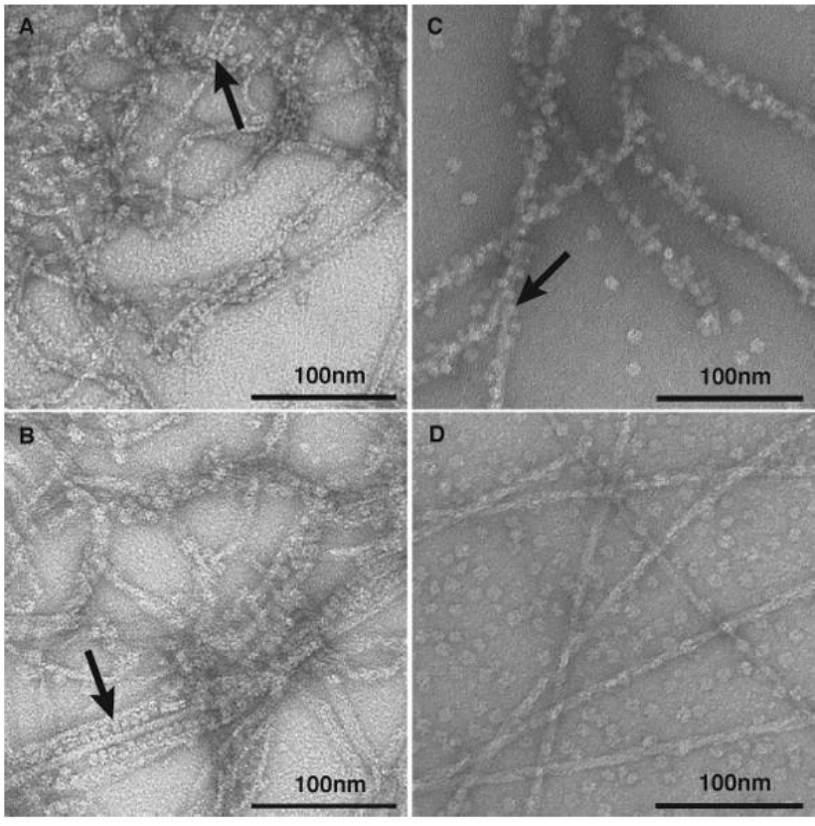
FIGURE 4. Effects of Aβ 31-35 fragment on catalase binding to human IAPP 1-37 and Aβ 17-40 fibrils. The human IAPP (A) and Aβ (C) fibrils both bound catalase (example indicated by arrow